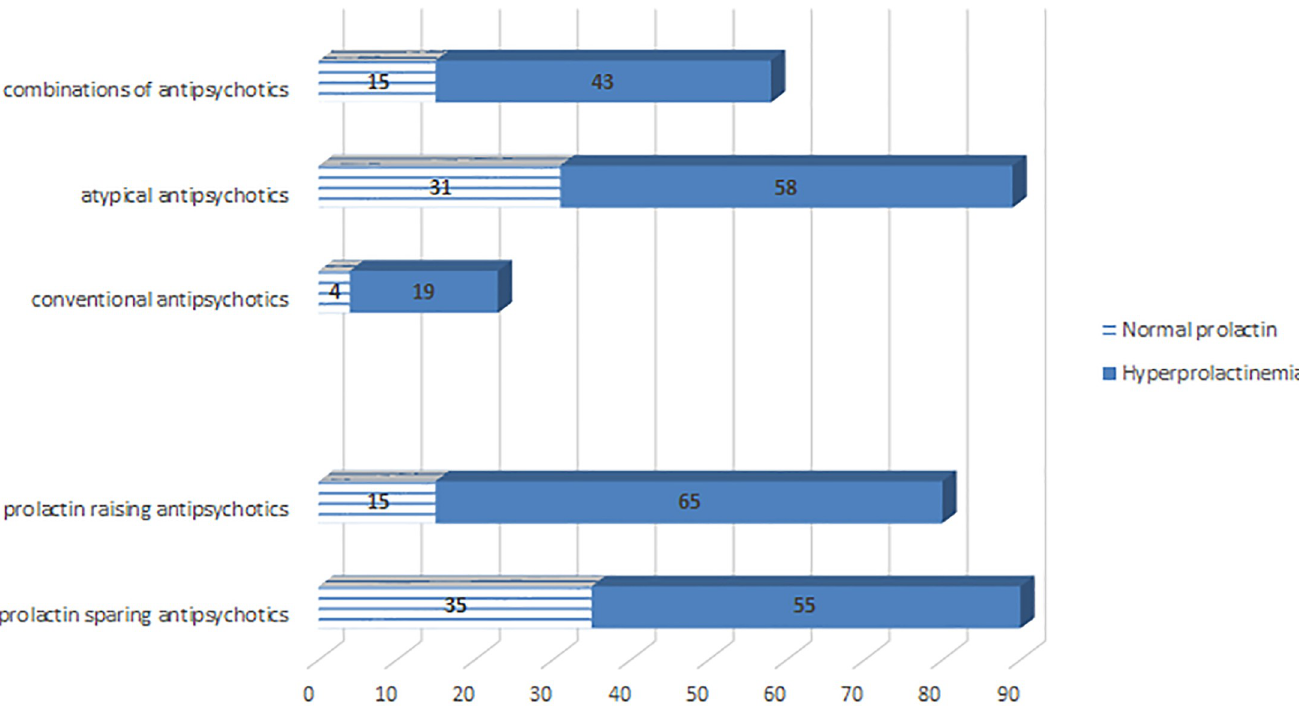
Fig 2. Hyperprolactinemia and prescribed antipsychotic medication.